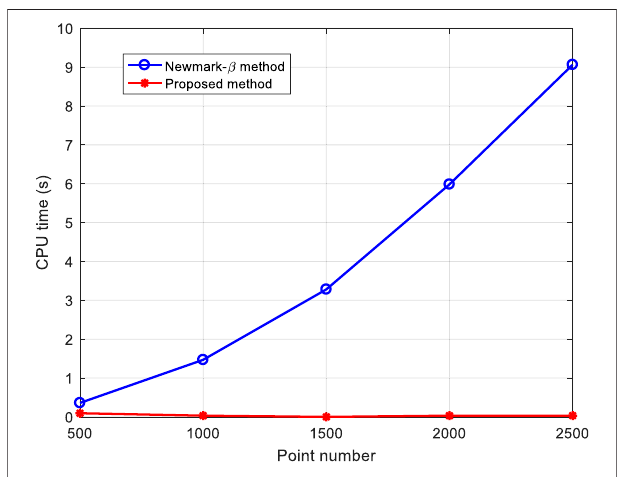
FIGURE 11 | Comparison of the computational ef fi